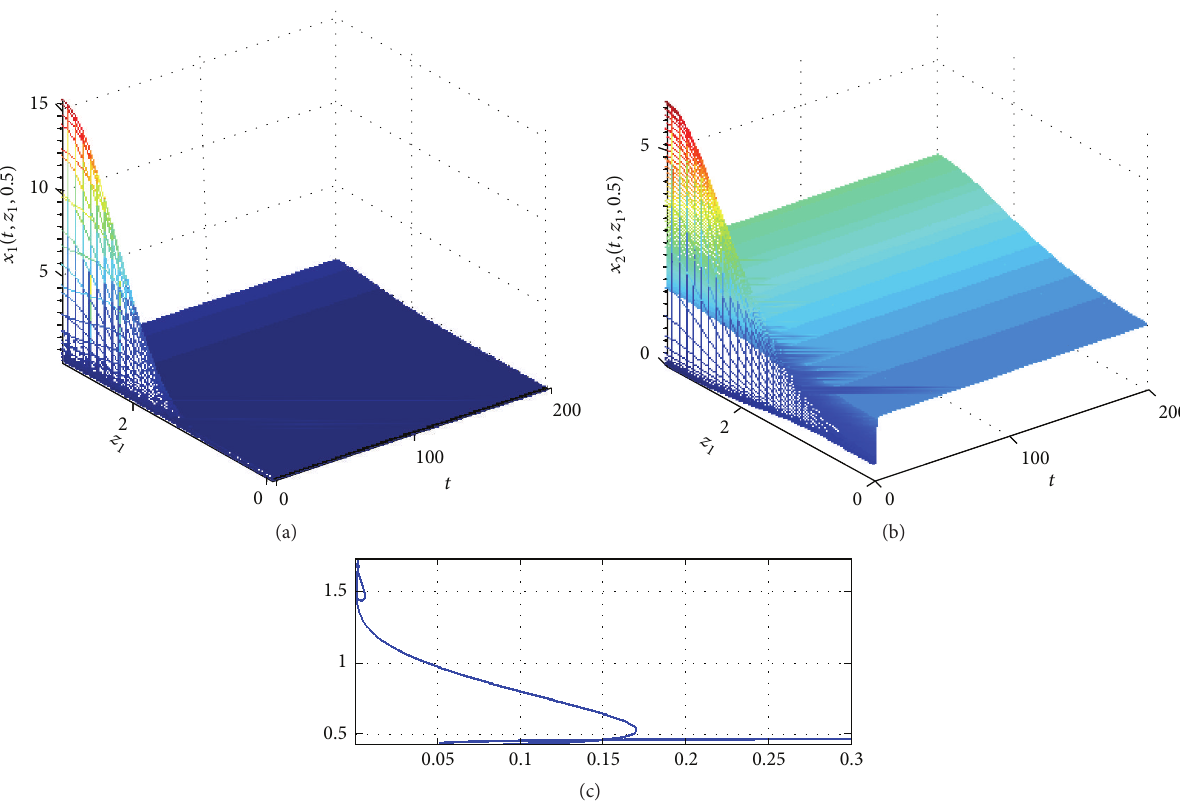
Figure3:Numericalresultsforthestateestimationanalysis.(a)Timespatialresponse 𝑥 1 (𝑡,𝑧 1 ,0.5) in (𝑡,𝑧 1 ) domain.(b)Timespatialresponse 𝑥